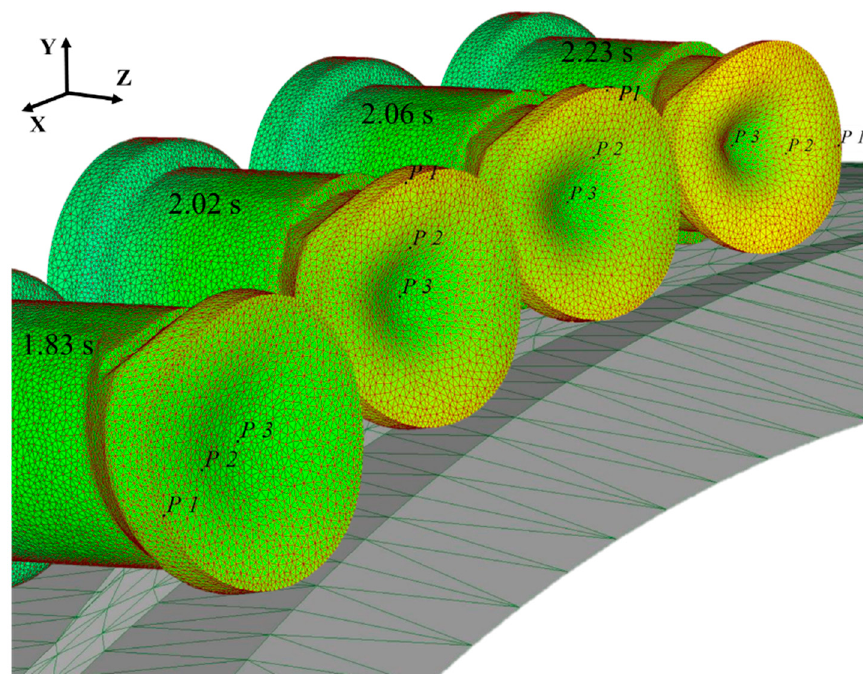
Figure 7. Variation of the rolling piece in the rotation period of 1.83–2.23 s.